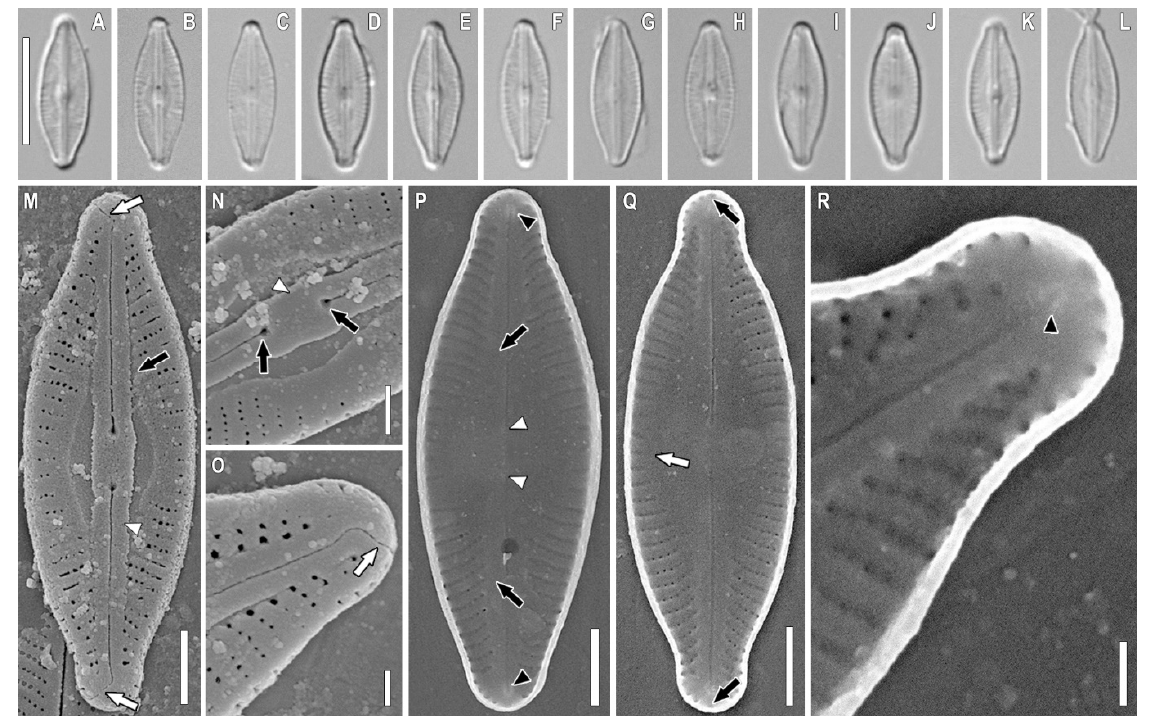
Figure 1. Sellaphora terrestris sp. nov. Strain VP 304. Slide no. 07062a. ( A – L ). Light microscopy, differential interference contrast, size diminution series ( M ). Scanning electron microscopy, external views. ( M – O ). Scanning electron microscopy, internal views. ( P – R ). Black arrow shows the longitudinal grooves in the axial area. White arrows show the distal raphe ends. White arrowhead shows the conopeum. ( N ). Black arrow shows the proximal raphe ends. White arrowhead shows the conopeum. ( O ). White arrows show the distal raphe end. ( P ). Black arrow shows the axial area. Black arrowheads show the helictoglossae. White arrowheads show the central raphe ends. ( Q ). Black arrows show the rounded apical pits. White arrow shows the areolae covered by hymenes ( R ). Black arrowhead shows the helictoglossa. ( G ). Holotype. Scale bar ( A–L ) = 10 μ m; ( M,P,Q ) = 2 μ m; ( N ) = 1 μ m; ( O,R ) = 0.5 μ m.